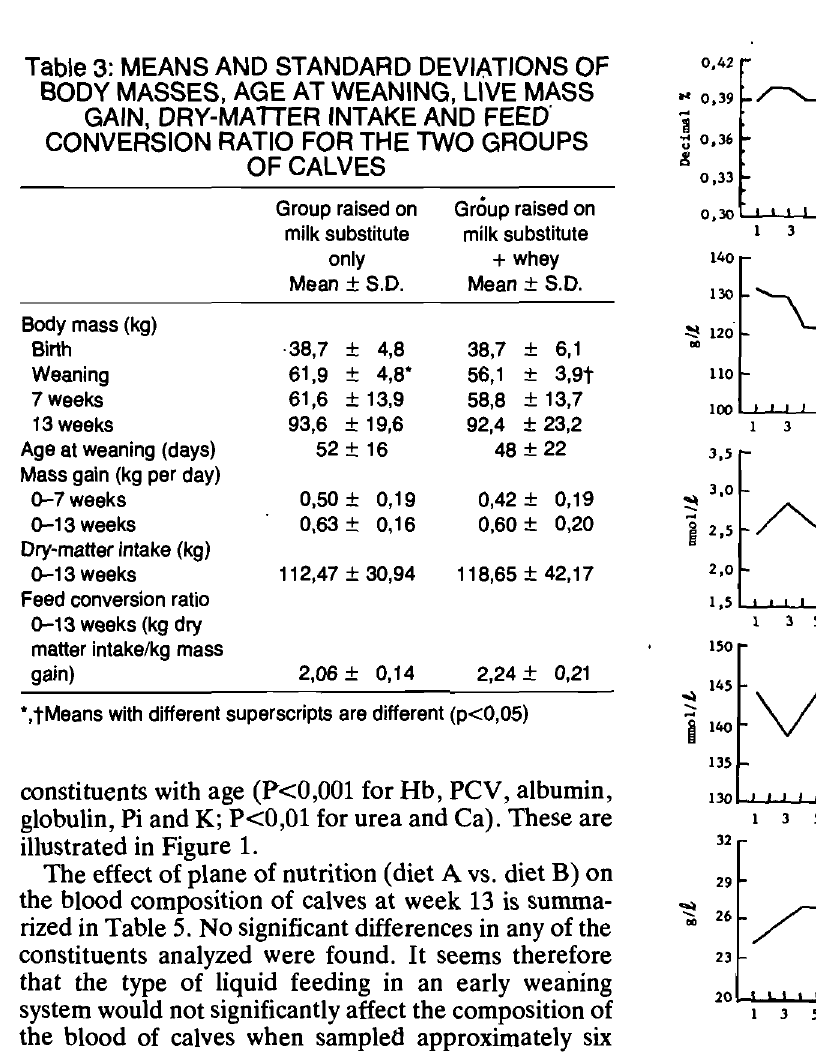
Fig. 1 Change in the mean PCV and concentrations of blood Hb and glucose and serum urea, Pi, Mg, Ca, Na, K, albumin and globulin with age for 16 calves.